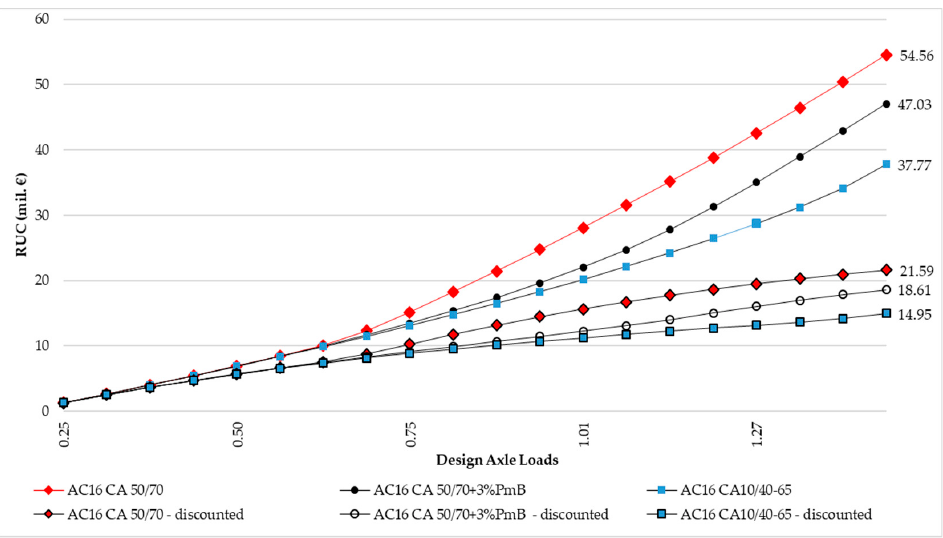
Figure 8. Cumulative road user cost: undiscounted and present value (discounted with 5% discount rate).